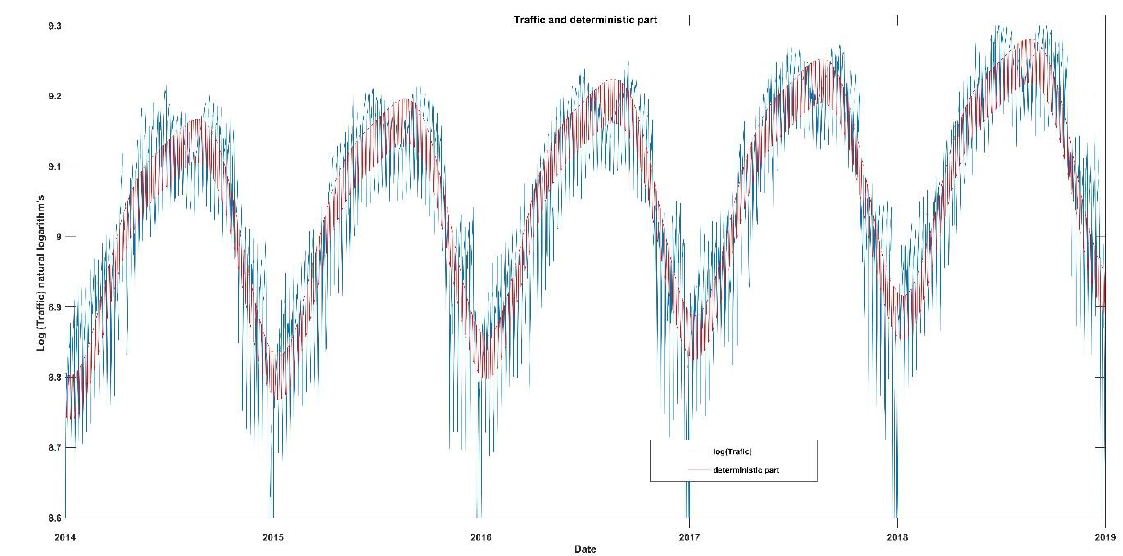
Figure 4. Natural logarithm of number of flights and the estimated deterministic part